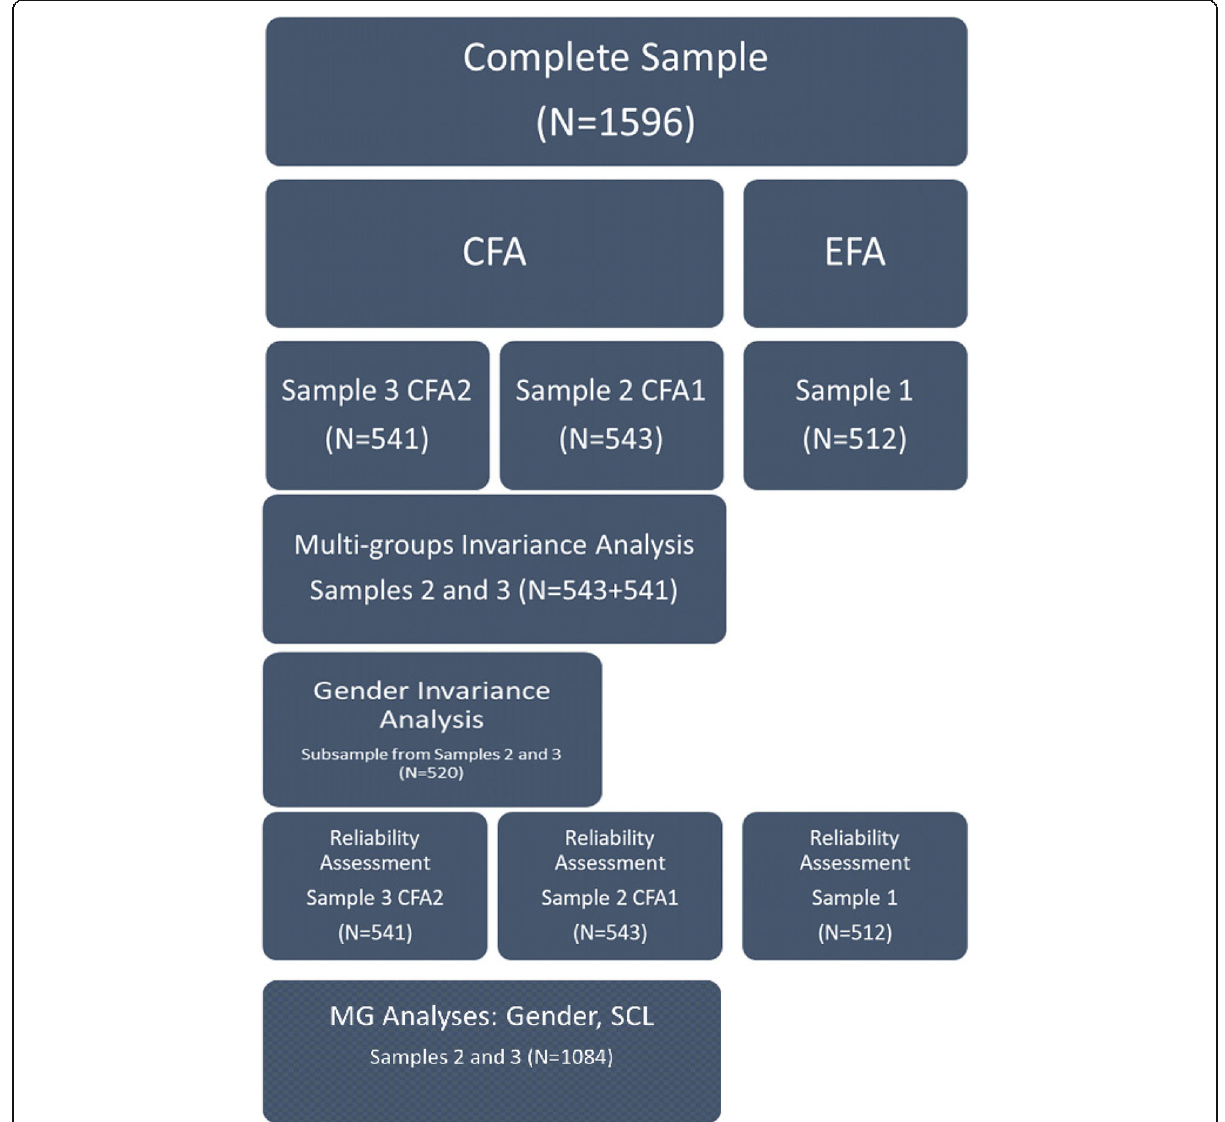
Fig. 1 Data analysis procedure and